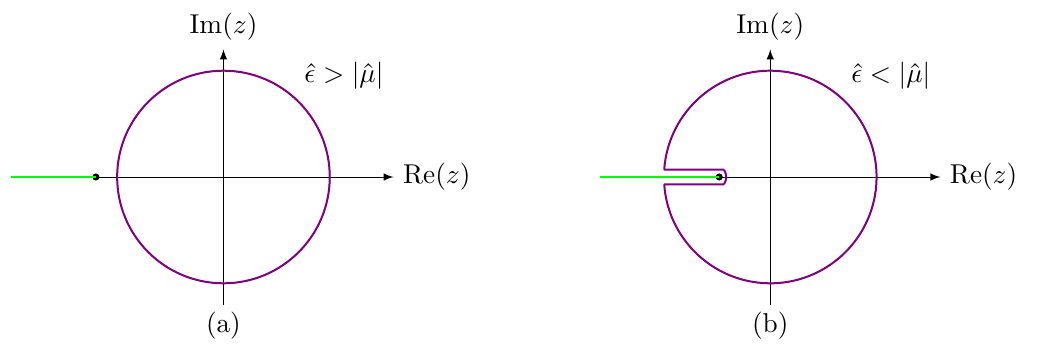
Figure 9 . Fermions in non-lower gap phases: the branch point is at z = − e ˆ (cid:15) −| ˆ µ | and is denoted by the black dot on the -ve real axis. The purple curve is the contour (counterclockwise) over which the holonomy is integrated over in this phase. The green line is the branch cut for the logarithm appearing in the fermionic free